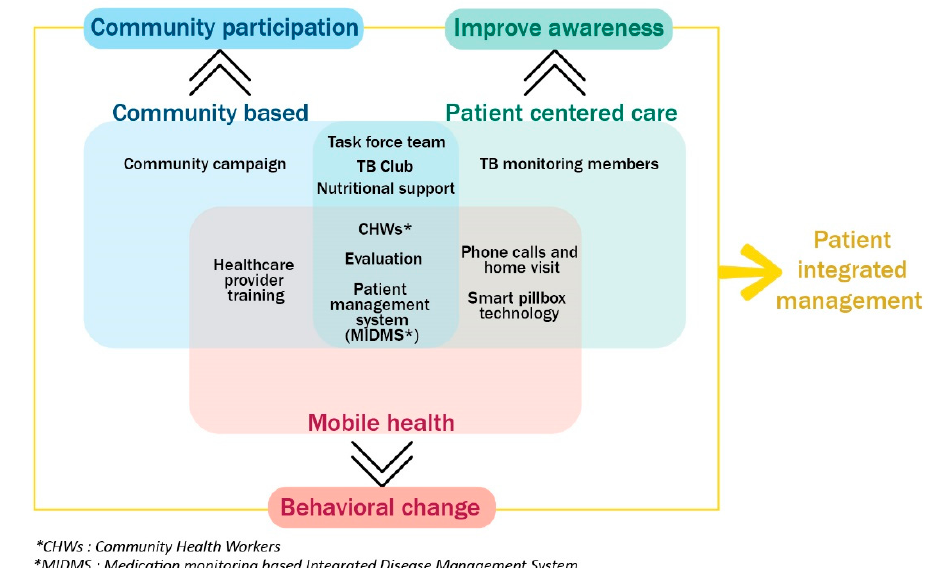
Figure 2. Program conceptual framework.